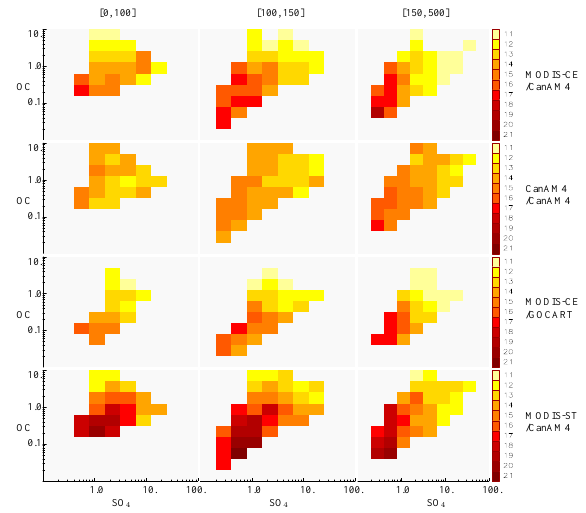
Fig. 6. Cloud effective radius (in µm) as a function of sulphate and organic carbon concentrations (units: mg/m 2 ). Results for effective radius from MODIS-CE (top panel), CanAM4 (second panel) using aerosol concentrations from CanAM4. Results for effective radius from MODIS-CE and simulated aerosol concentrations from GOCART, and the results for effective radius from MODIS-ST and simulated aerosol concentrations from CanAM4 are shown in the third and bottom panel, respectively. The data were stratified by using cloud liquid water path from CanAM4 simulations (columns, units: g/m 2 ).